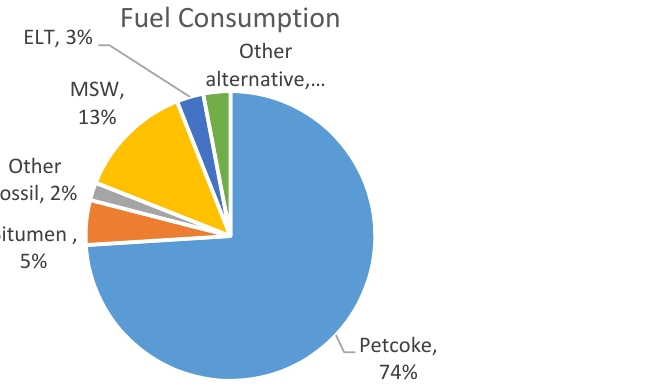
Figure 13. NACE 23.51 EA analysis: distribution of thermal consumption by fuel (ELT—end-of-life tyres, MSW—municipal solid waste).